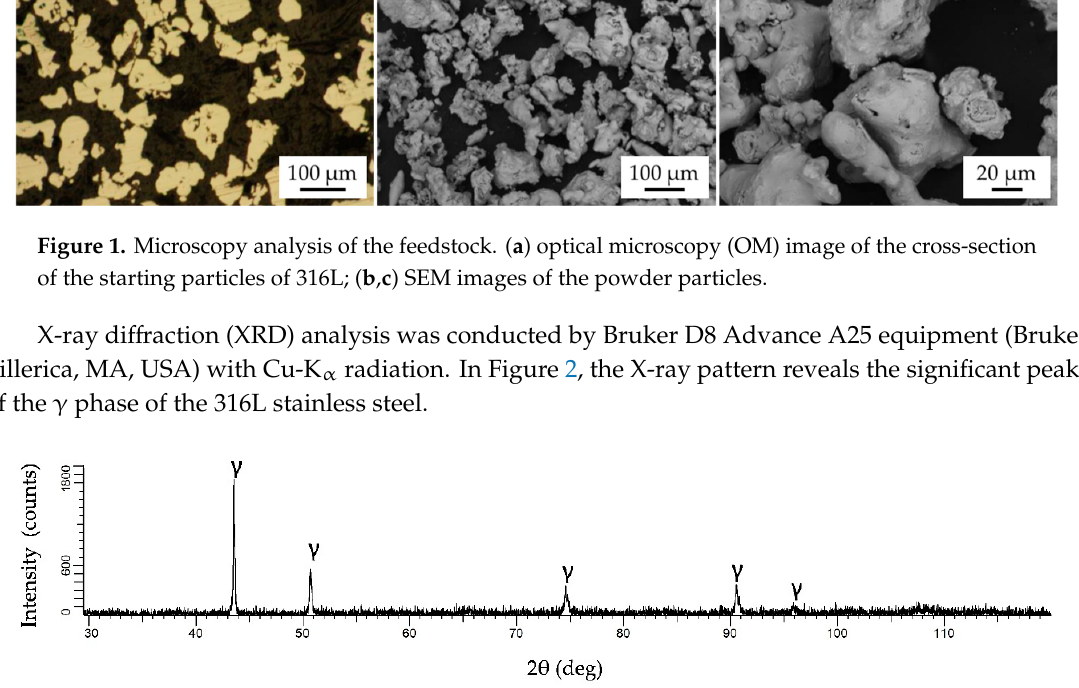
Figure 2. XRD analysis of the starting powder.